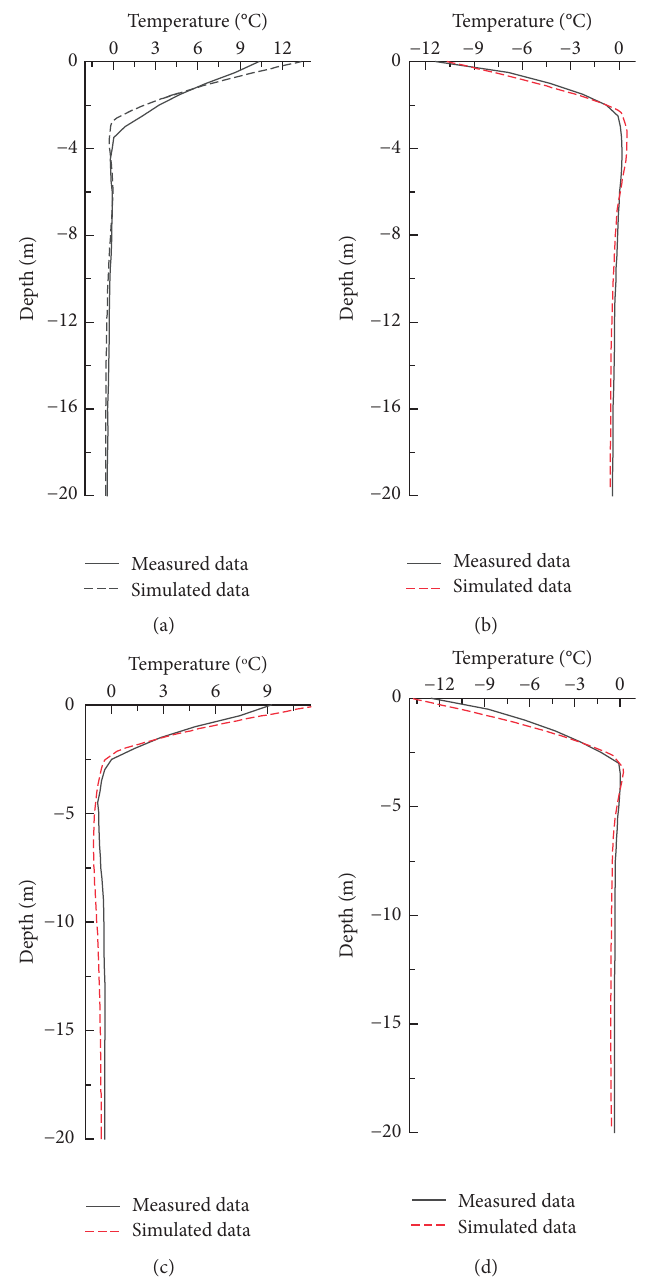
Figure 8: Simulated and measured temperature values at different depths on the sunny and shady slope. (a) Sunny shoulder Jul. 2012. (b) Sunny shoulder Jan. 2013. (c) Shady shoulder Jul. 2012. (d) Shady shoulder Jan.